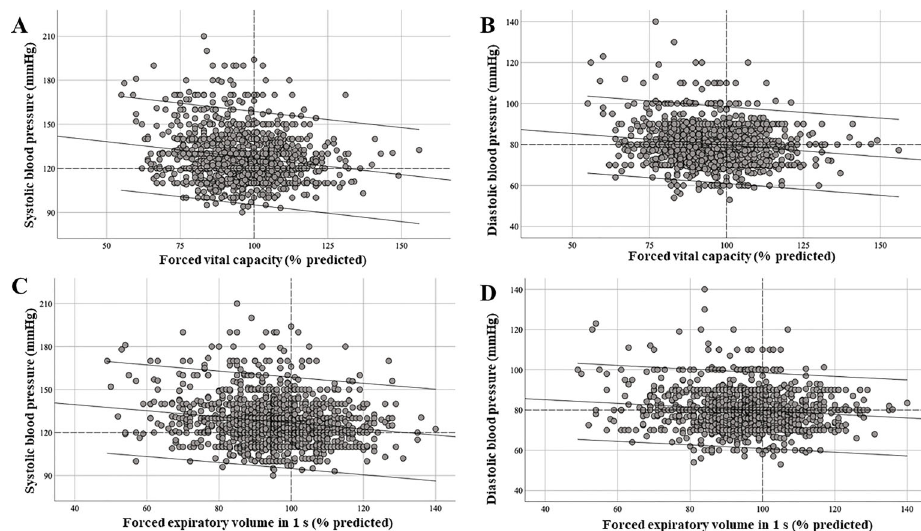
Figure 3. Correlations between lung function and blood pressure. ( A ) Forced vital capacity vs systolic blood pressure (r = – 0.289; P o 0.0001); ( B ) forced vital capacity vs diastolic blood pressure (r = – 0.256; P o 0.0001); ( C ) forced expiratory volume in 1 s vs systolic blood pressure (r = – 0.269; P o 0.0001); ( D ) forced expiratory volume in 1 s vs diastolic blood pressure (r = – 0.203; P o